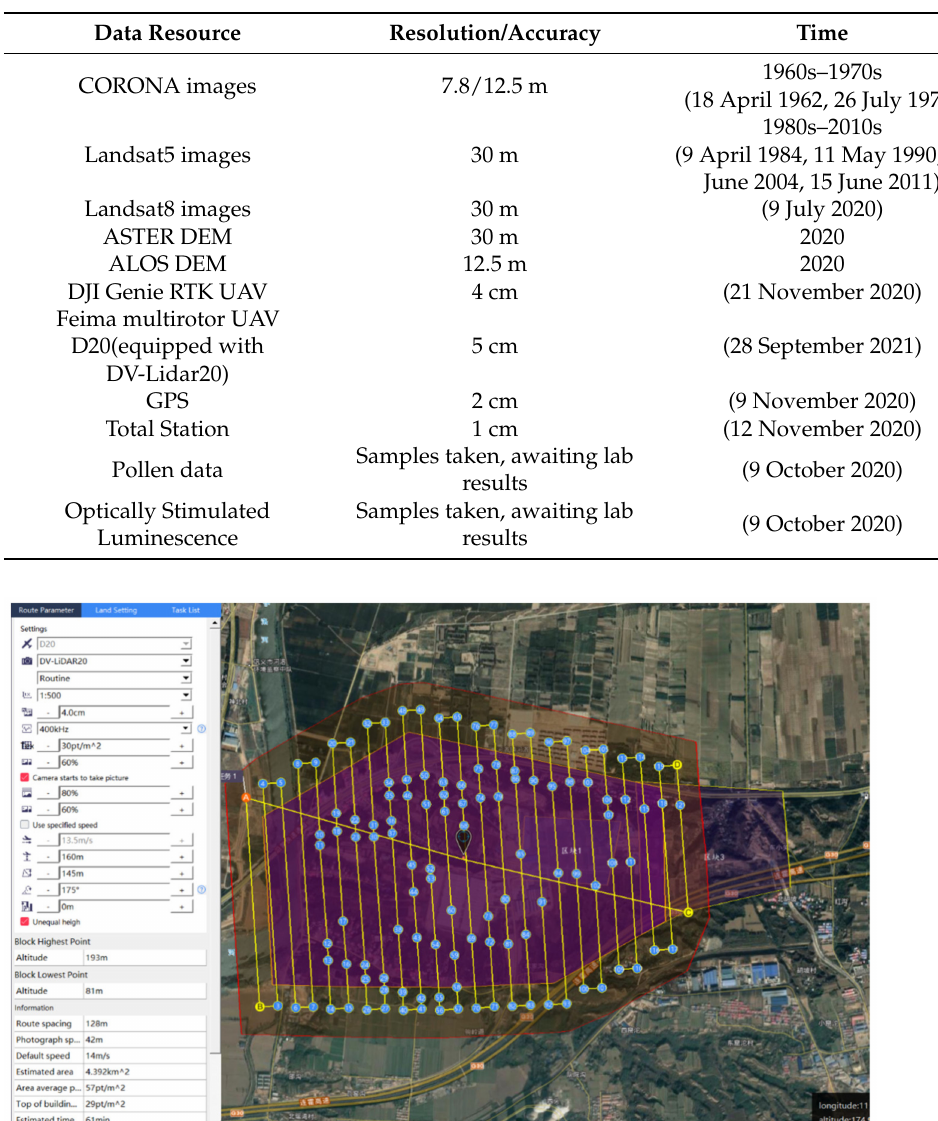
Table 1. Data source information.